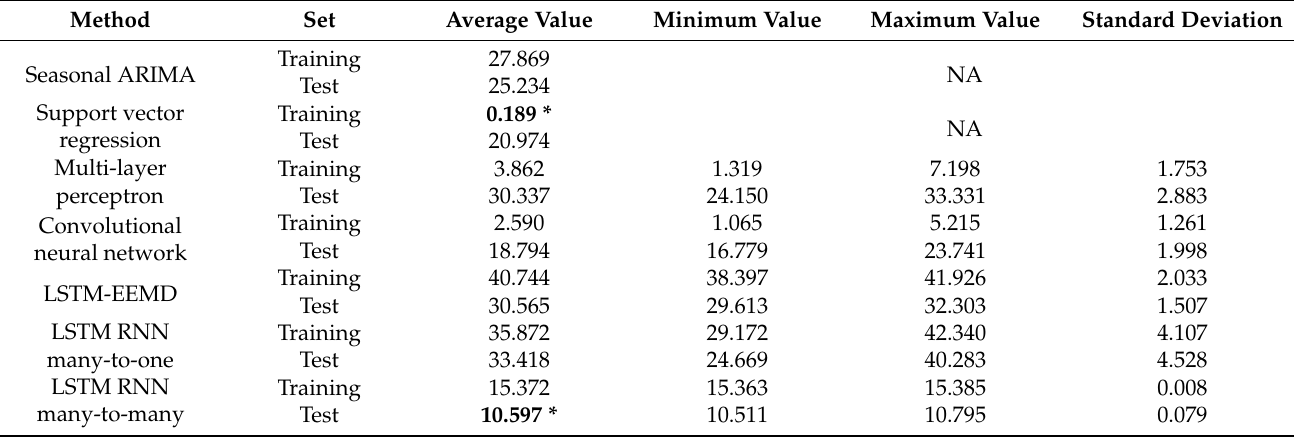
Table 8. Root mean square error for actual dataset.